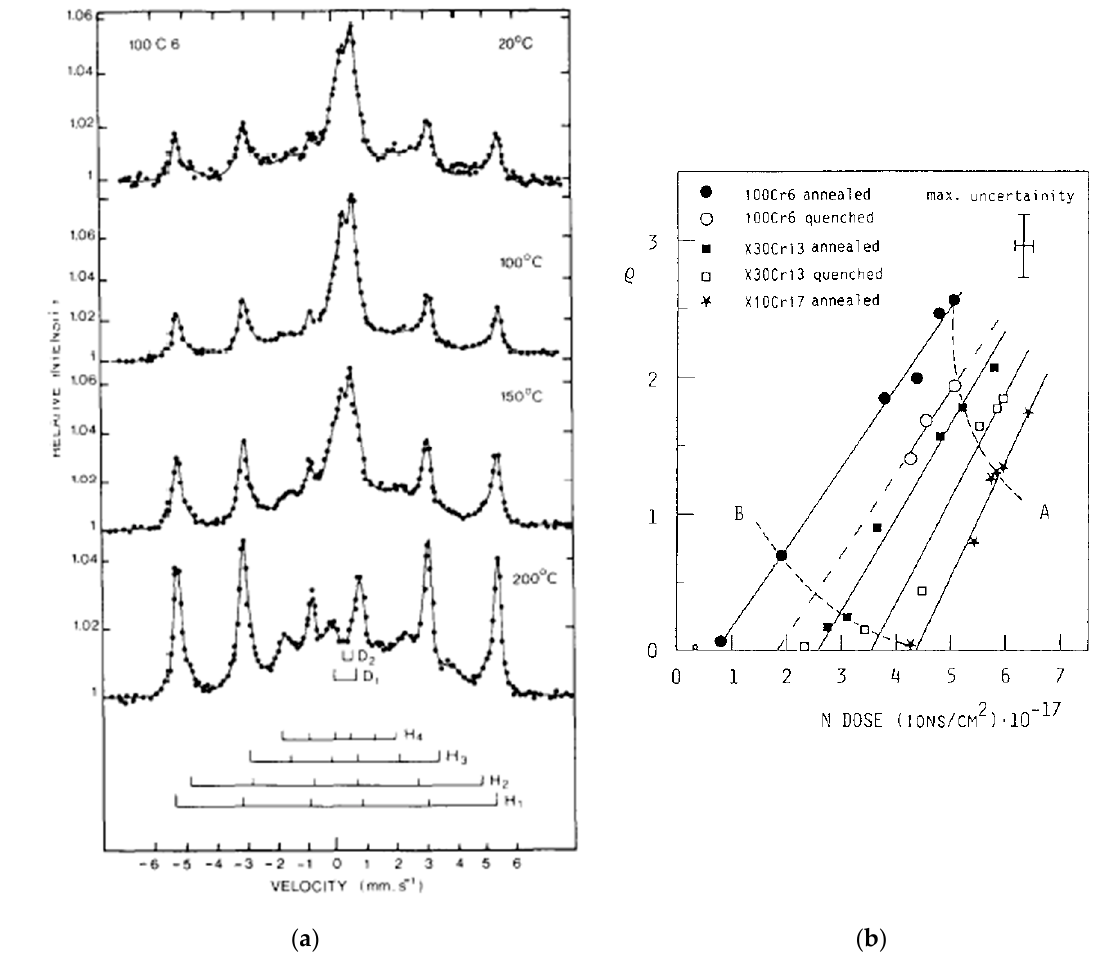
Figure 18. ( a ) CEMS profiles of 100 C6 (AISI 52100) steel implanted with a 40 keV nitorgen dose of 2 × 10 (cid:2869)(cid:2875) N (cid:2878) cm (cid:2879)(cid:2870) at different temperatures. Recognized spectral components: H (cid:2869) = metallic 10 17 N + cm − 2 at di ff erent temperatures. Recognized spectral components: H 1 = metallic Fe, H 2 = α (cid:48) Fe, H (cid:2870) = α (cid:4593) martensite, H (cid:2871) and H (cid:2872) = magnetic ε − Fe (cid:2870)(cid:2878)(cid:2934) (C,N), D (cid:2869) = non magnetic ε − martensite, H 3 and H 4 = magnetic ε -Fe 2 + x (C,N), D 1 = non magnetic ε - Fe 2 + x ( C,N ) , D 2 = non Fe (cid:2870)(cid:2878)(cid:2934) (C, N) , D (cid:2870) = non magnetic ε − Fe (cid:2870)(cid:2878)(cid:2934) (N). Reproduced from [48], with permission from magnetic ε -Fe 2 + x ( N ) . Reproduced from [47], with permission from North-Holland Physics Publishing North-Holland Physics Publishing Division, 1986. ( b ) Behaviour of 𝜌 (ratio between areas of Division, 1986. ( b ) Behaviour of ρ (ratio between areas of Mössbauer components due to iron nitrides Mössbauer components due to iron nitrides and to the matrix) as a function of the measured N dose, and to the matrix) as a function of the measured N dose, parametrically with the Cr content of the steel parametrically with the Cr content of the steel (straight lines). Curves A and B cross data points (straight lines). Curves A and B cross data points corresponding to implants at 50 and 140 µ A cm − 2 , corresponding to implants at 50 and 140 𝜇 A cm (cid:2879)(cid:2870) , respectively, of annealed samples. Reproduced respectively, of annealed samples. Reproduced from [48], with permission from IOP Publishing, from [49], with permission from IOP Publishing, 1959.